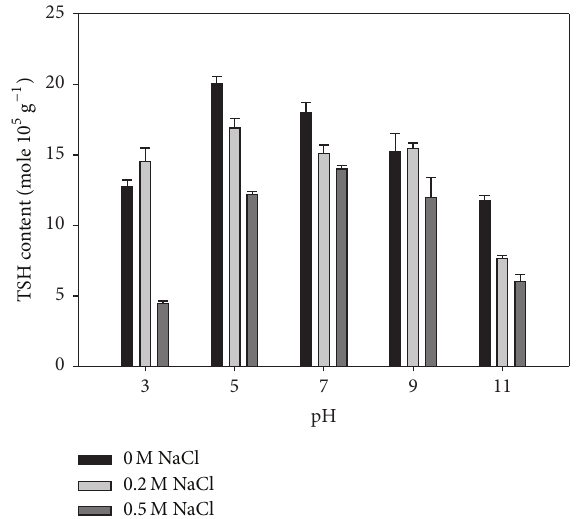
Figure 3: Effect of pH and NaCl concentration on total sulfhydryl (TSH) content in SP from jumbo squid mantle. Data represent the mean ± standard deviation ( 𝑛 = 3